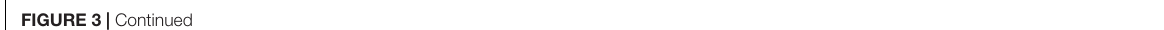
FIGURE 3 | Continued bar indicates 1 mm. (B) Qualitative phototaxis. Slug trails of WT AX2, tau, α -synuclein, and cotransformants were traced and digitised. Strains expressing α -synuclein showed no defect in phototaxis when compared to WT. Tau strains exhibited a reduced accuracy of phototaxis which was enhanced by the coexpression with α -synuclein. (C) Quantitative Phototaxis. WT AX2, tau, α -synuclein, and cotransformant strains were statistically analysed to measure the accuracy of phototaxis ( κ ), normalised, and were plotted againt cell density. Tau expressing strains displayed an impaired accuracy of phototaxis when compared with the WT AX2. This defect was more severe in the strains expressing tau and α -synuclein in combination. Error bars represent standard errors (D)